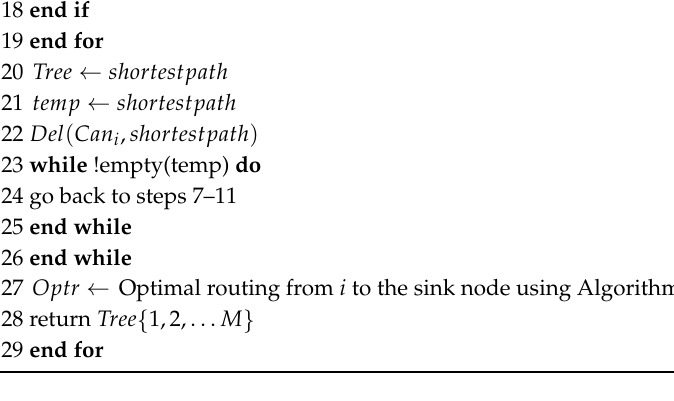
Algorithm 4. Sensor signal reconstruction.